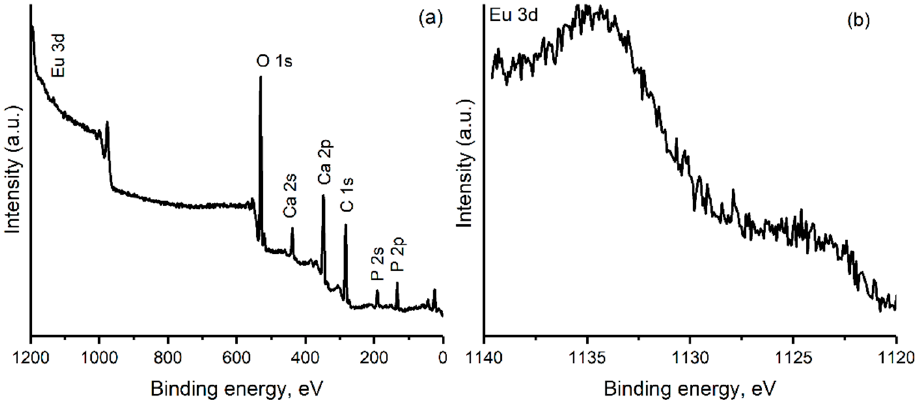
Figure 5. XPS general spectrum of 5EuHAp thin film ( a ) and high-resolution XPS spectrum of Eu 3d ( b ).